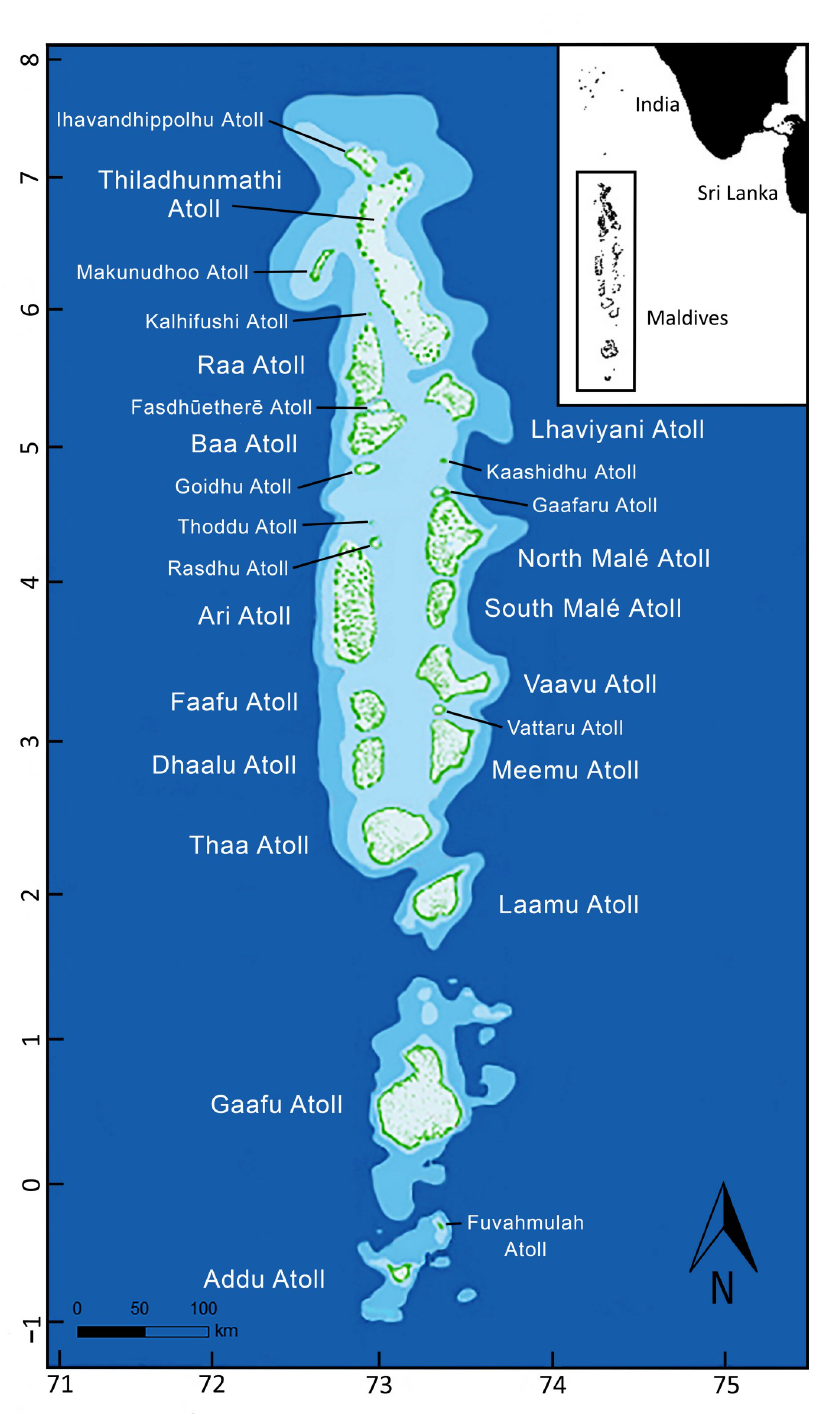
Fig 1. A map of the Maldives archipelago located to the southwest of India. Diagram shows the 26 geographical atolls illustrated in green.